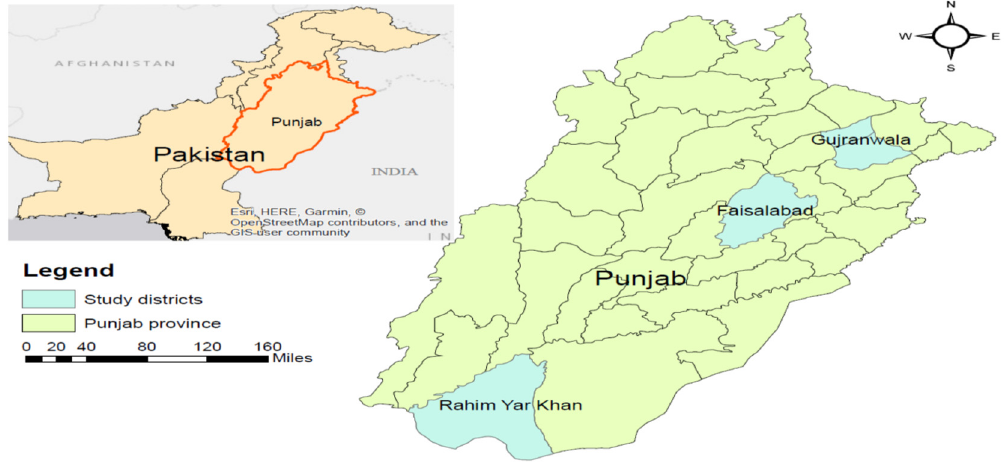
Figure 1. Research